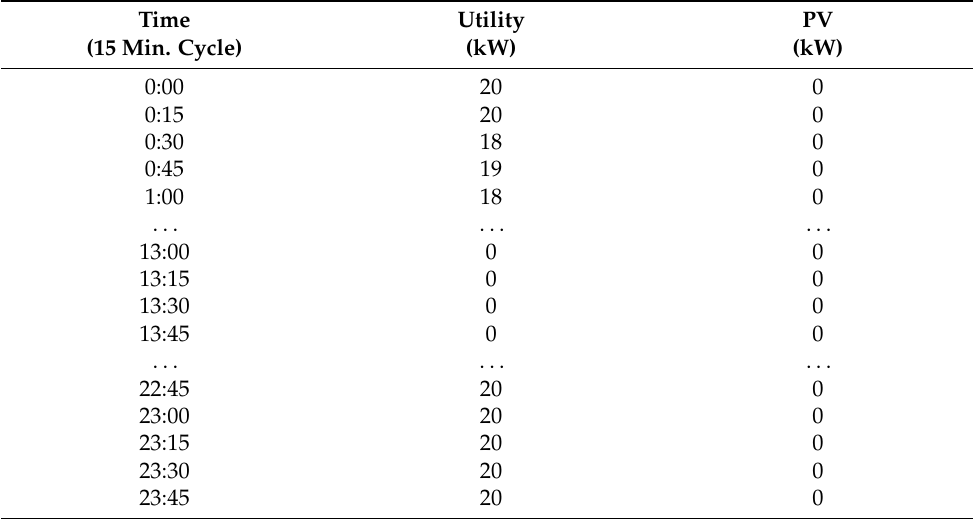
Table 4. Utility grid power supply and PV street generation in Case 3 (Cloudy Day).